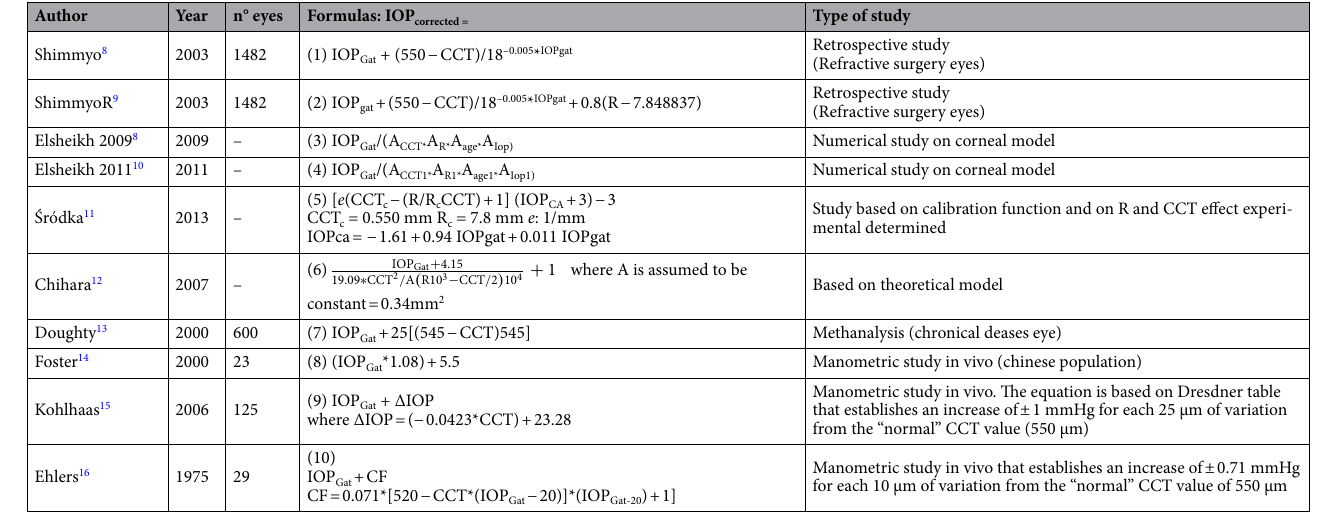
Table 1. informations about GAT correcting formulas